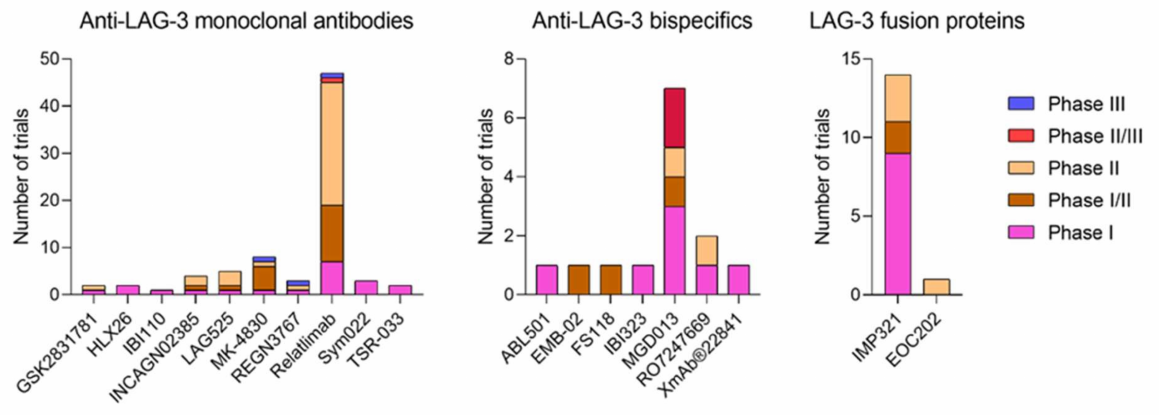
Figure 2. LAG-3-targeted therapy clinical landscape of phases for anti-LAG-3 monoclonal antibodies, bispecific molecules and fusion proteins clinically developed (https://clinicaltrials.gov/, accessed on 29 June